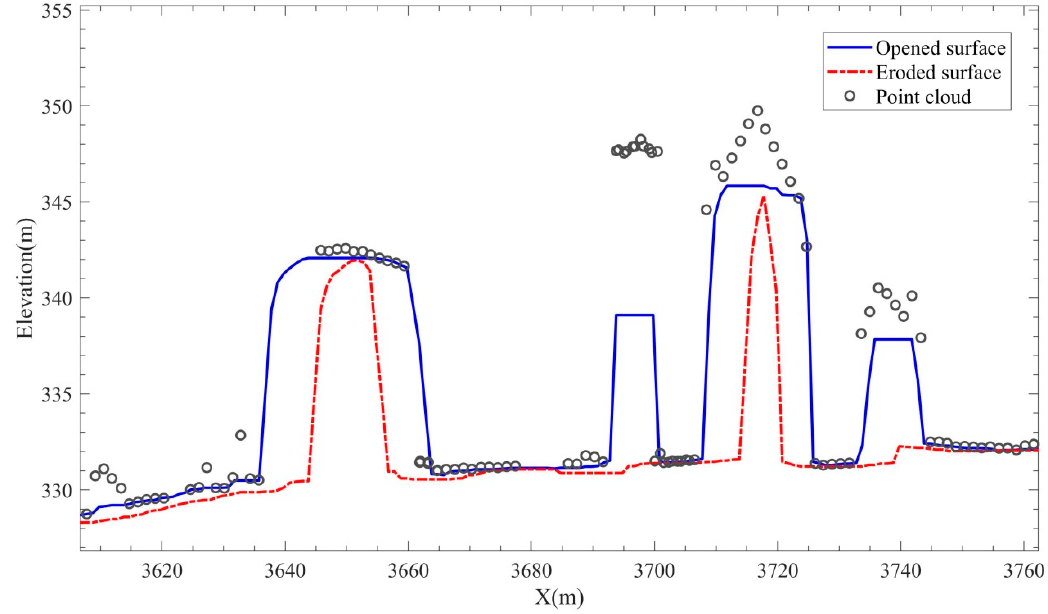
Figure 2. Schematic diagram of morphology-based filters.